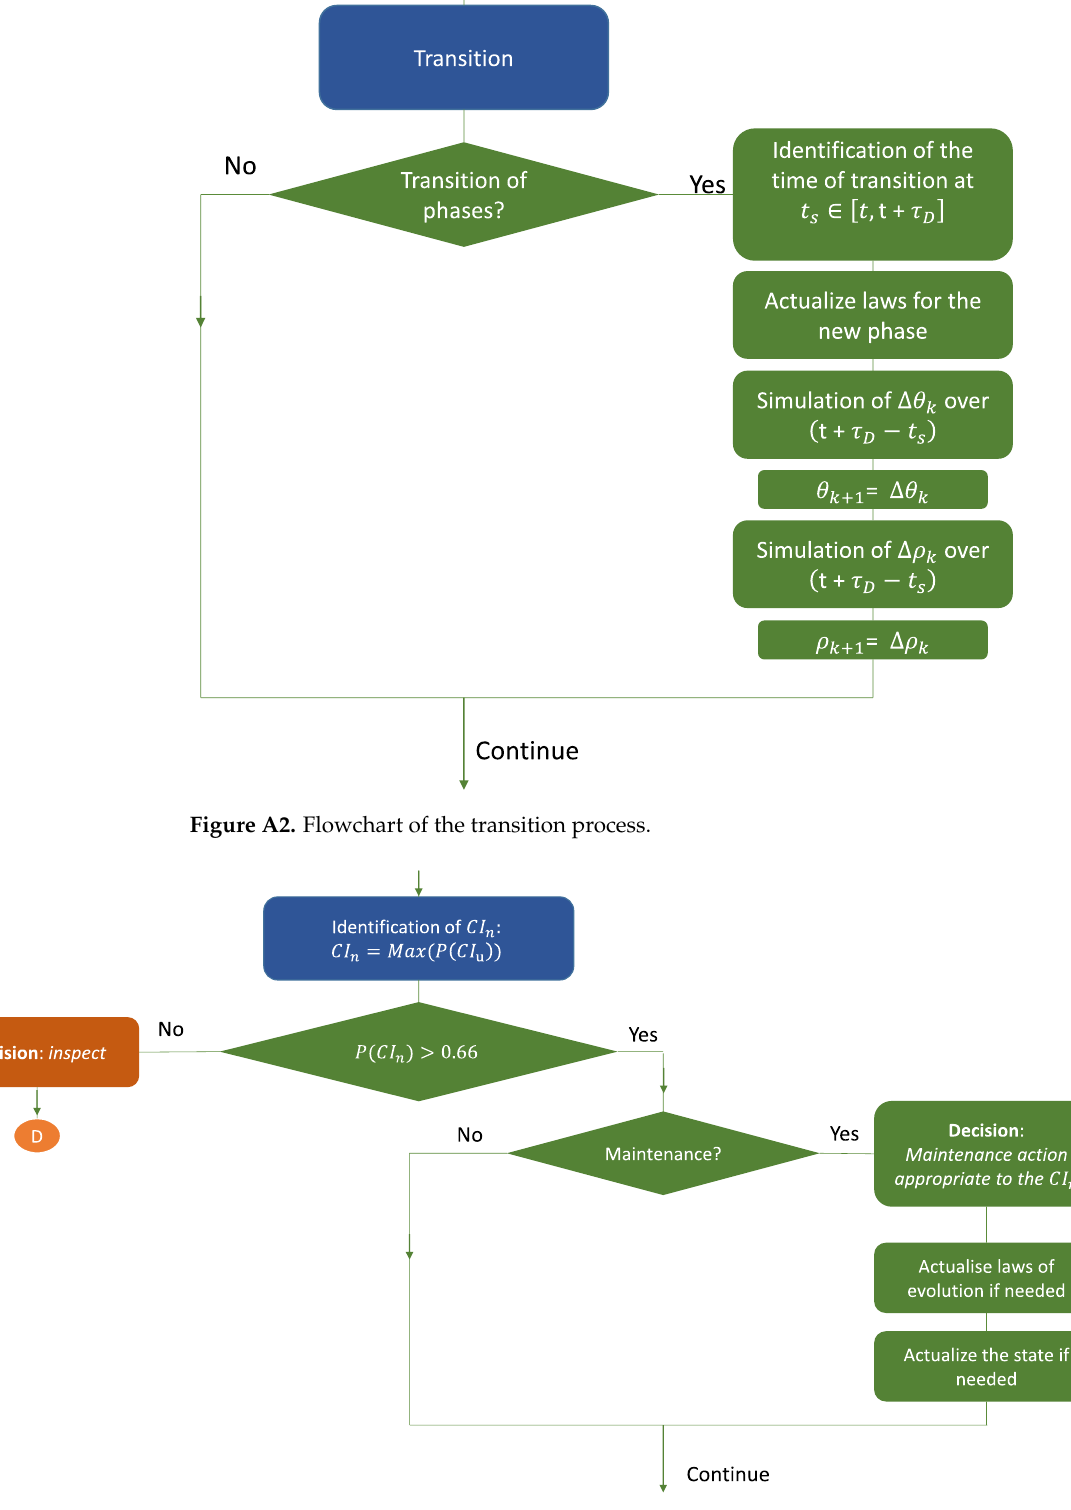
Figure A3. Flowchart of the decision process.